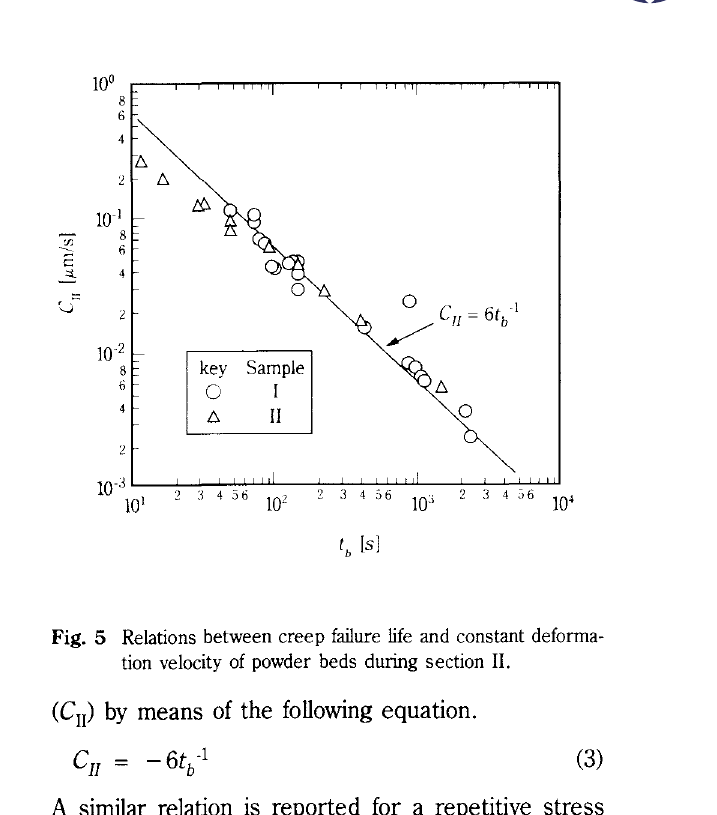
Fig. 5 Relations between creep failure life and constant deforma tion velocity of powder beds during section II.